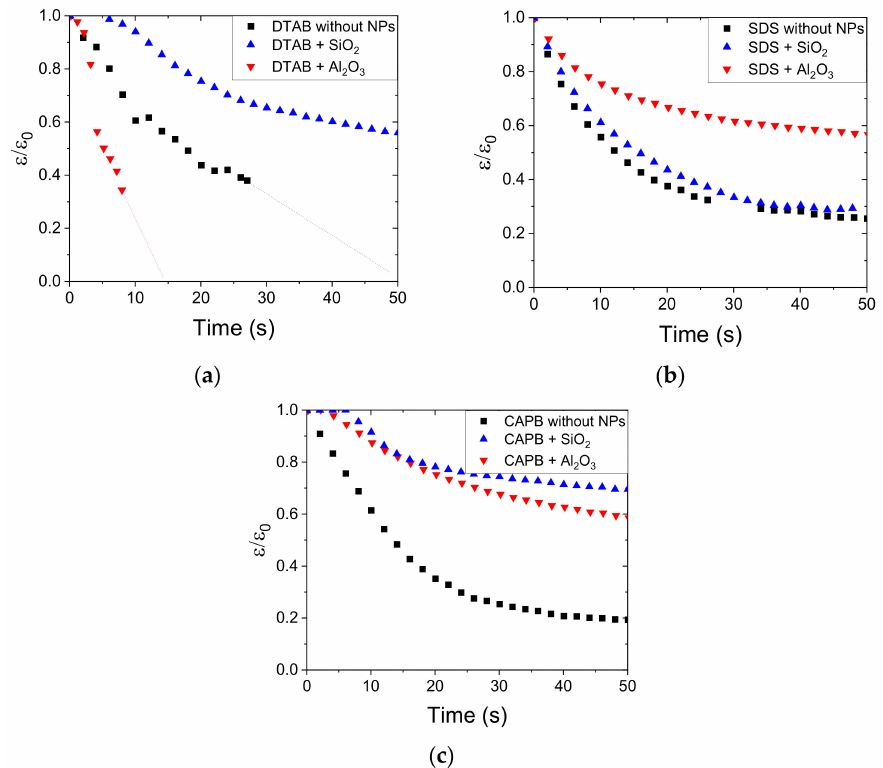
Figure 5. Normalised liquid content ( ε / ε 0 ) profiles with the time of CO 2 foams formed with ( a ) DTAB, ( b ) SDS, and ( c ) CAPB surfactants, in the absence and presence of 1.0 wt % SiO 2 or Al 2 O 3 (in desulphated seawater brine, at 25 ◦